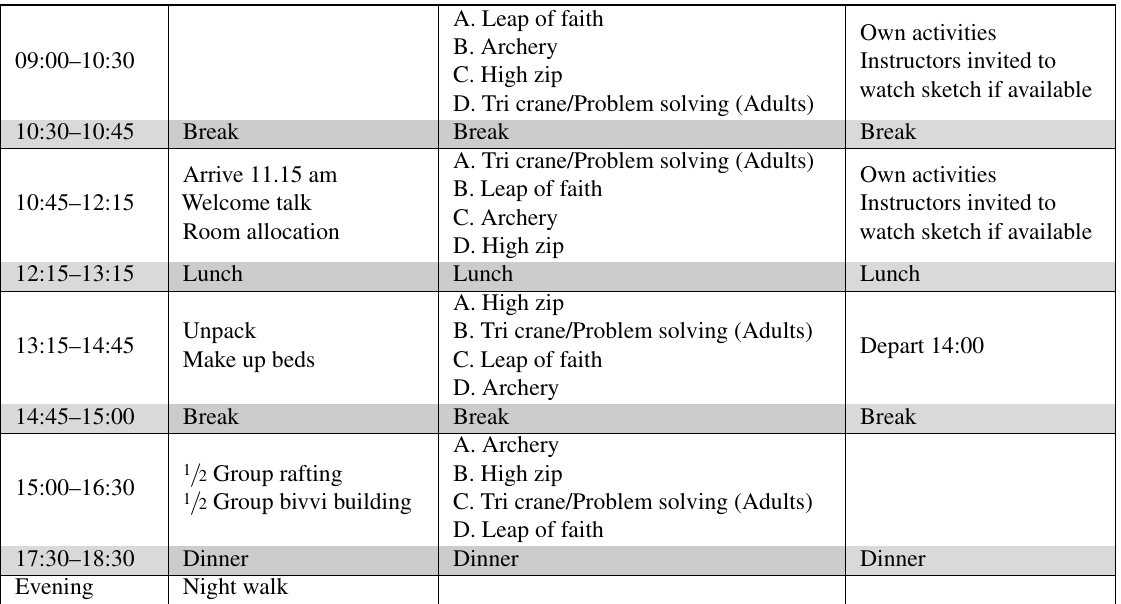
Table 1. Timetable of